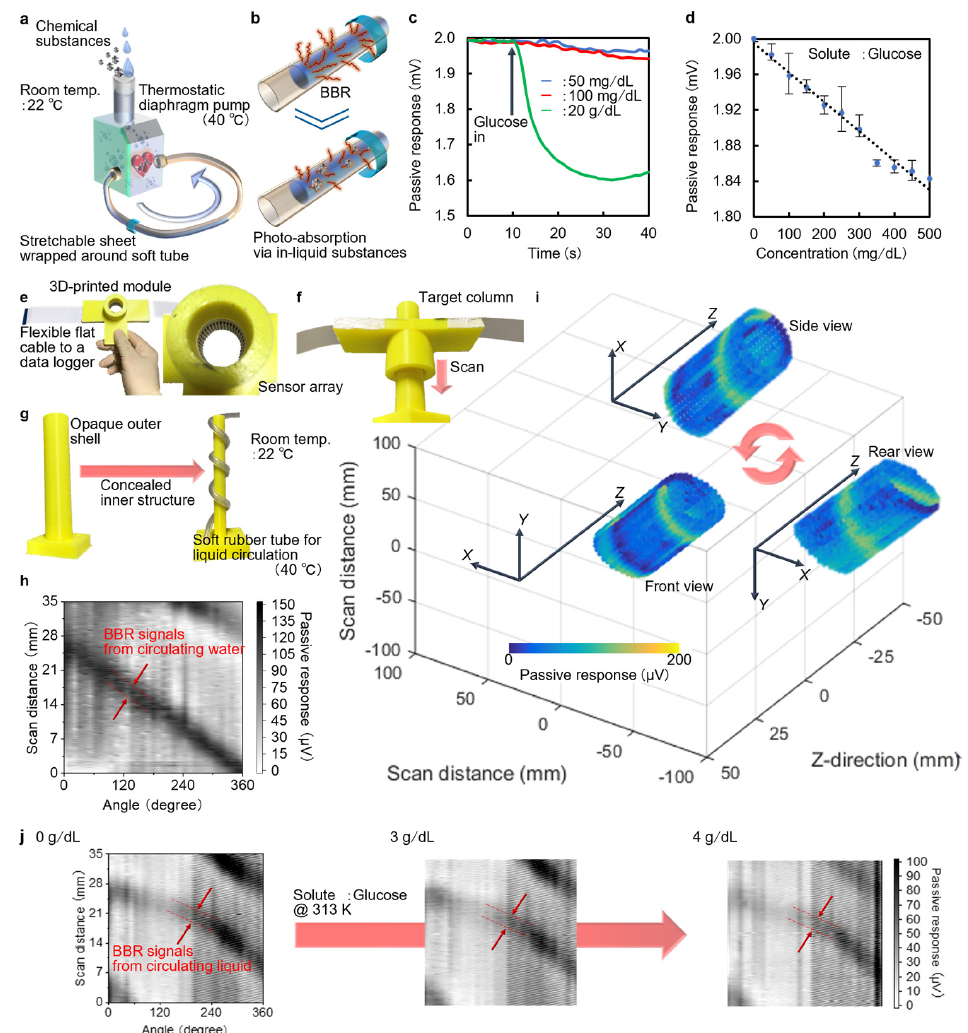
Figure 7. Demonstrations of passive-style non-destructive, on-site, and dynamic monitoring of in-liquid chemicals. ( a ) Schematic of the experimental setup. ( b ) Operating mechanism. ( c ) Changes in the device’s PTE responses against the amount of glucose powder dissolution to the circulating liquid. ( d ) Concentration monitoring of the glucose solution. ( e ) Photographs of the porTable 360° around-view PTE imager with the CNT-film-based PTE sensor sheet. ( f ) Experimental setup for the BBR-based 360° around-view passive imaging of the spirally circulating liquid. ( g ) Photographs of the target. ( h ) 360° around-view PTE image. ( i ) 3D PTE image reconstruction of the target. ( j ) Comparison in BBR-induced 360° around-view PTE images of the spirally circulating glucose solution against concentration. ( a – j ): Reproduced with permission from [26] Copyright 2022, the authors, published by American Association for the Advancement of Science.